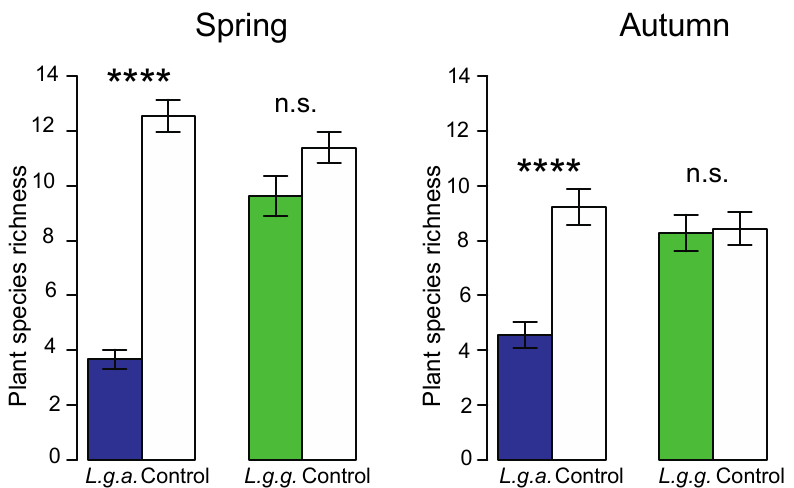
Figure 7. Plant species richness (number of species per 3 m 2 ) recorded in Lamium galeobdolon subsp. argentatum and Lamium galeobdolon subsp. galeobdolon plots, and the corresponding control plots in both spring and autumn. Mean values ± s.e. are shown, n = 18. Differences were tested using paired t -tests; **** p < 0.0001, n.s. not significant). Analysis of similarity (ANOSIM) revealed that species composition of the ground vegetation differed significantly between spring and autumn ( R = 0.504, p < 0.001), and between the three forests ( R = 0.609, p < 0.001). Overall, the two subspecies caused